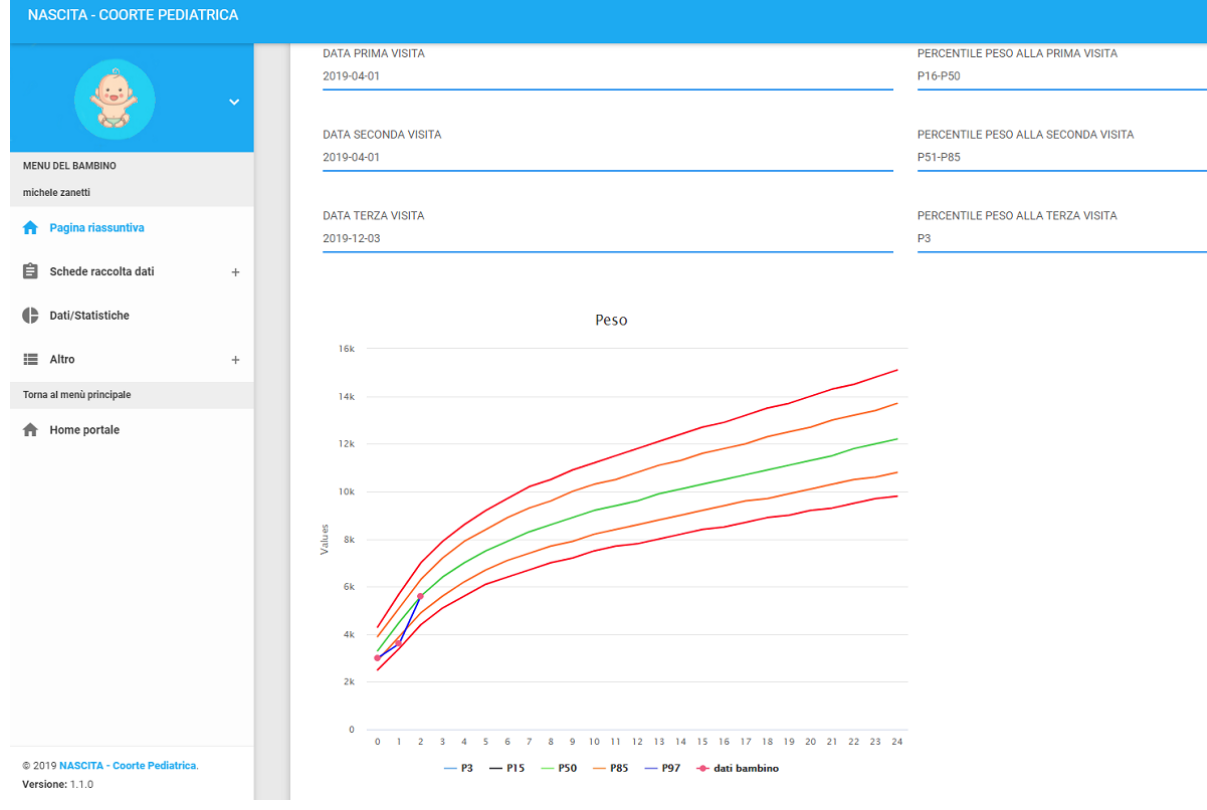
Figure 3. Individual child’s data plotted on growth curve, as seen by the